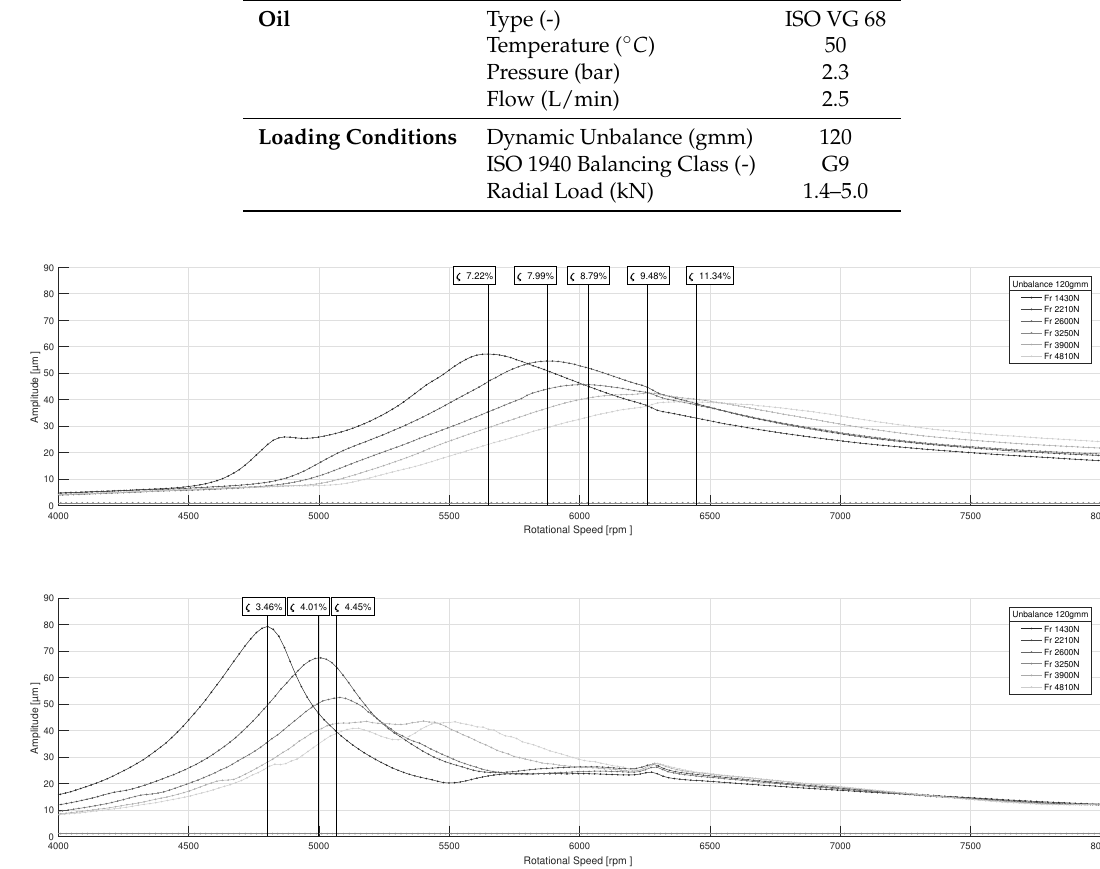
Figure 10. Amplitude response plot for the rotor system with damper active under 120 gmm unbalance excitation and increasing radial loading. The top graph resembles Virtual Probe A in vertical direction and the bottom graph depicts Virtual Probe B in horizontal